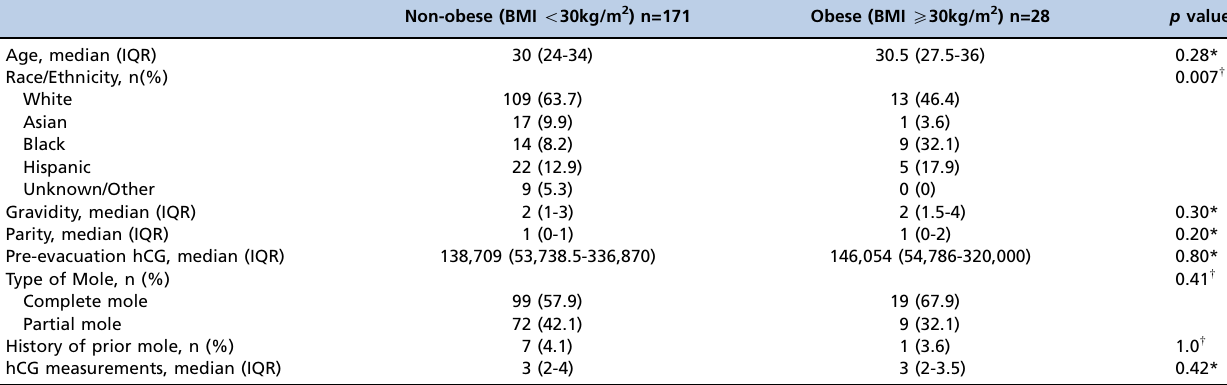
Table S5 - Characteristics of women with hydatidiform molar pregnancies by body mass index (BMI).